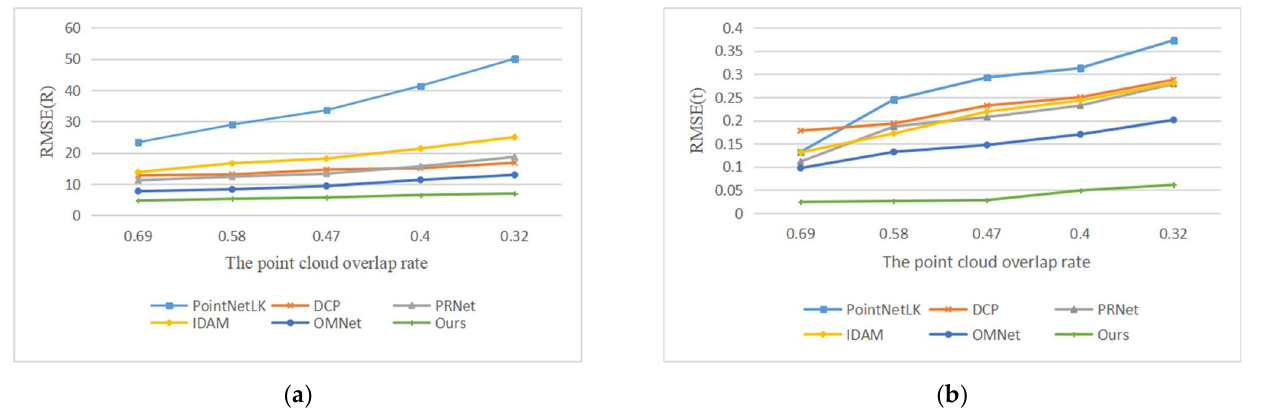
Figure 9. Errors of different overlapping rates. ( a ) The experimental results of compared methods in terms of RMSE(R); ( b ) The experimental results of compared methods in terms of RMSE(t).